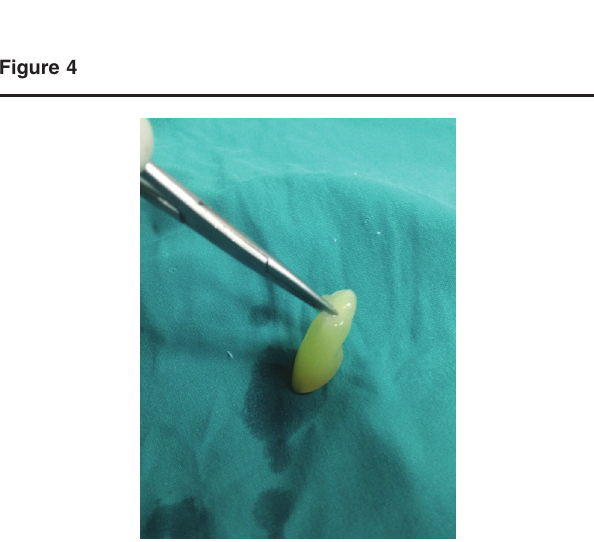
The PRF clot after